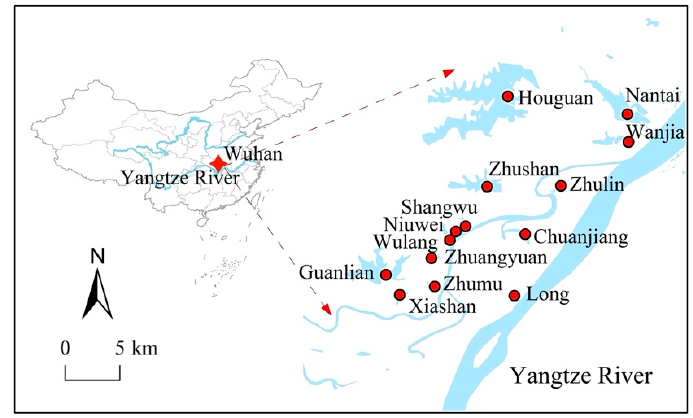
Figure 1. The location of the analyzed urban lakes in the present